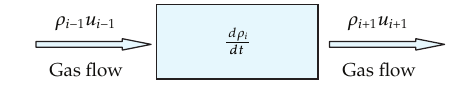
Figure 6: Conservation of